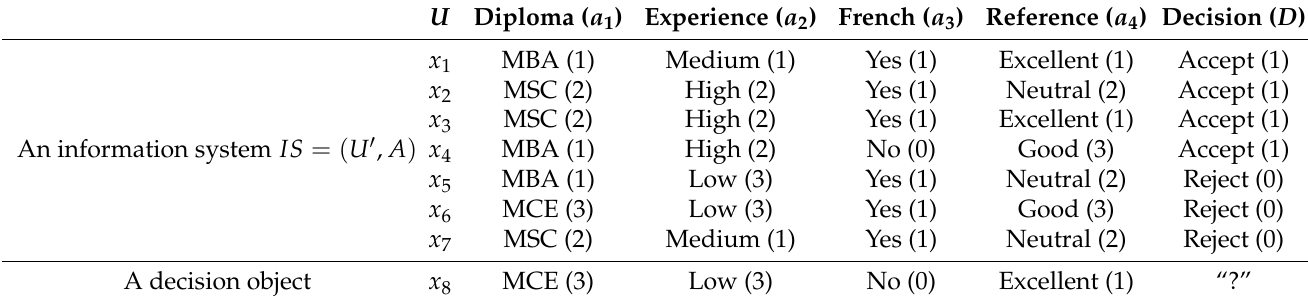
Table 5. A decision problem in the hiring